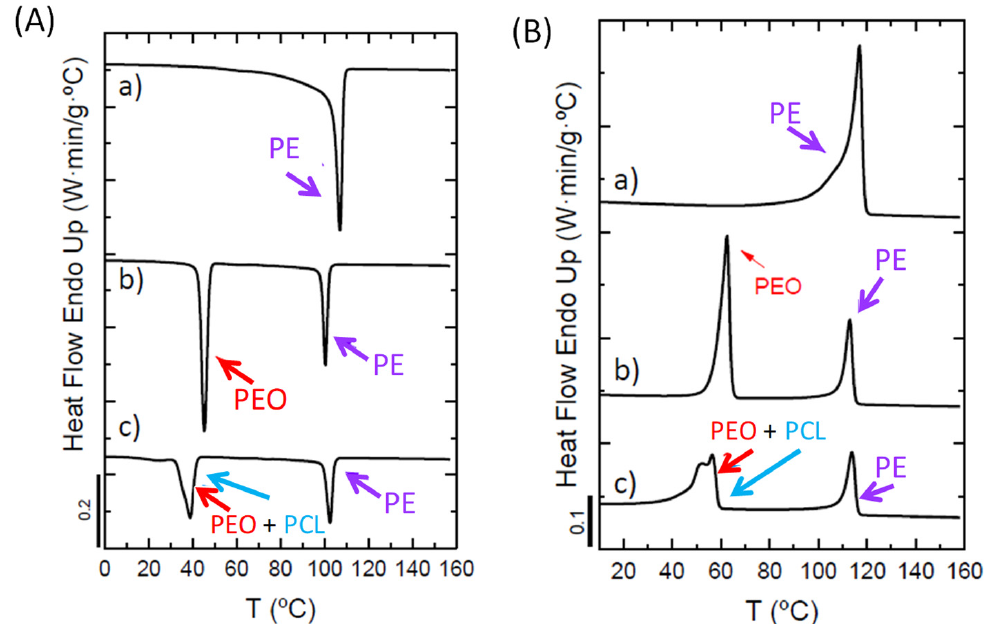
Figure 4. DSC scans at 20 ◦ C/min for (a) PE 9.5 , (b) PE 529.5 - b -PEO 488.8 , and (c) PE 379.5 - b -PEO 348.8 - b -PCL 297.6 (T2) of ( A ) cooling from the melt and ( B ) subsequent heating with arrows indicating transitions for each block.